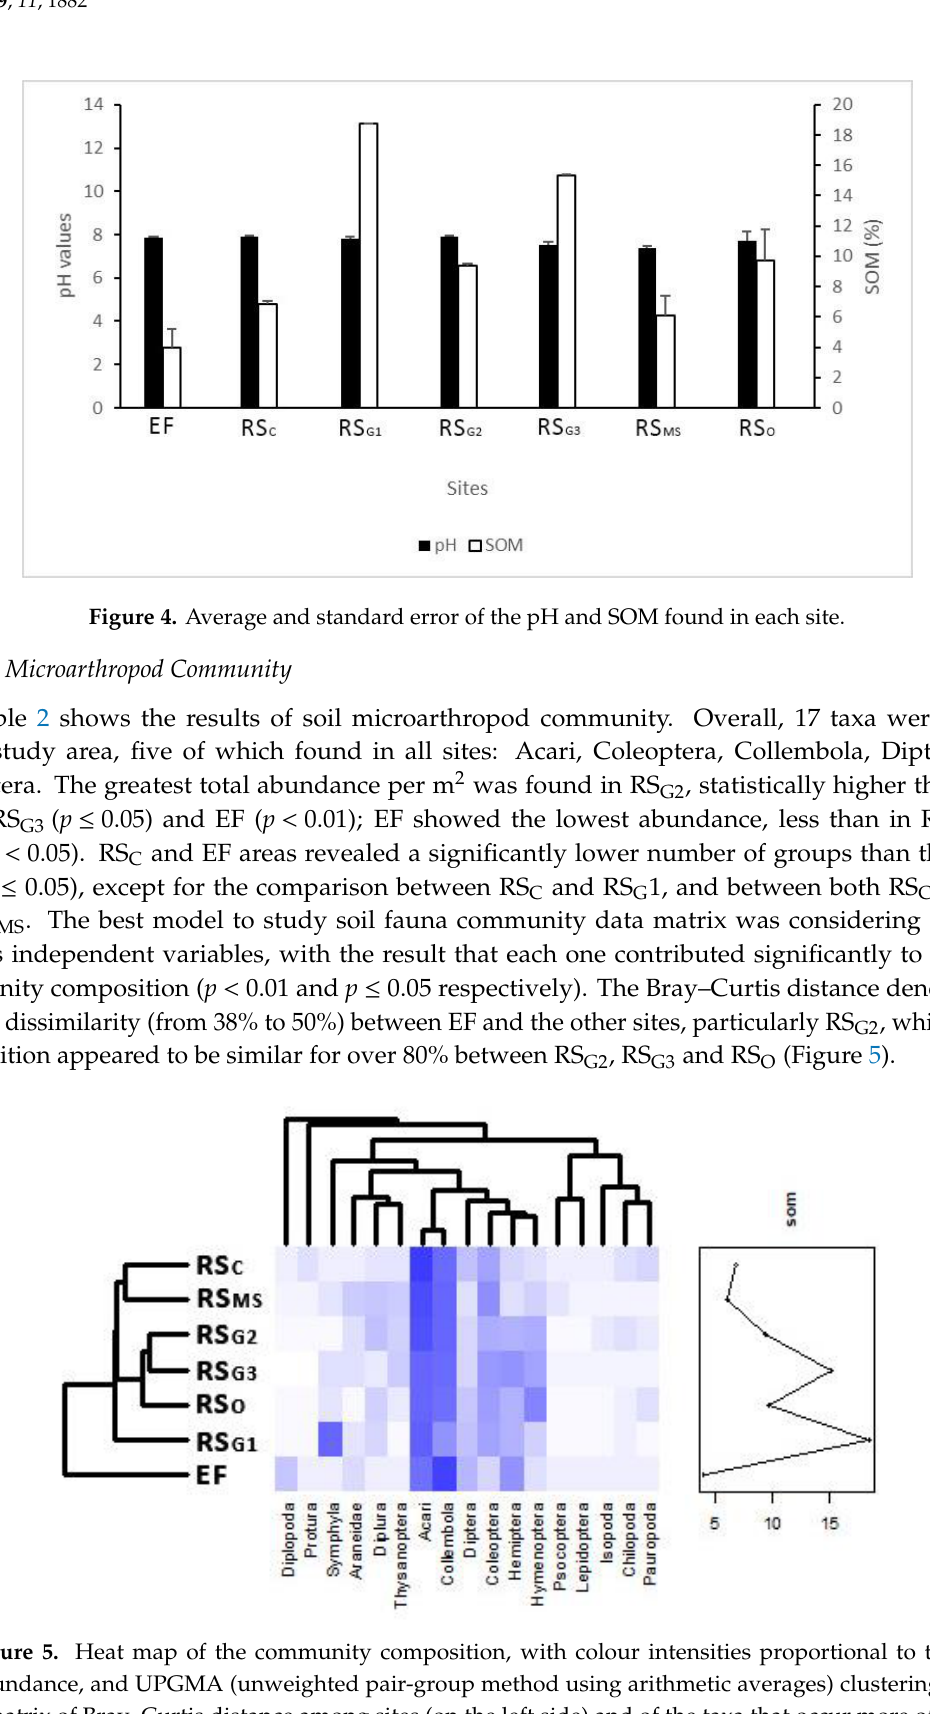
Greater Acari abundance was found in RS G2 , significantly higher than in RS C (p < 0.05) and EF sites (p < 0.01); in EF their presence was lower than RS O and RS G1 (p < 0.05). Among them, a distinction was made between those belonging to Oribatida and to other Acari (Figure 6). The Acari community strongly depends on the site (p ≤ 0.01); with EF abundance of Oribatida significantly lower than that of the other sites (p < 0.05) except for RS C (lower than RS G2 , p < 0.05) and RS MS . The abundance of Oribatida was greater than other Acari in RS G3 and RS O only. Figure 6. Average and standard error of the number of Oribatida and others Acari (ind./m²) found in each site. Like Acari, less abundant Coleoptera and Collembola were found in EF. The number of Coleoptera in EF was lower than in RS G3 and in RS O (p < 0.05). The abundance of Collembola observed in RS G2 was statistically greater than in RS G1 and in EF (p < 0.05, p < 0.01). Ten Collembola families